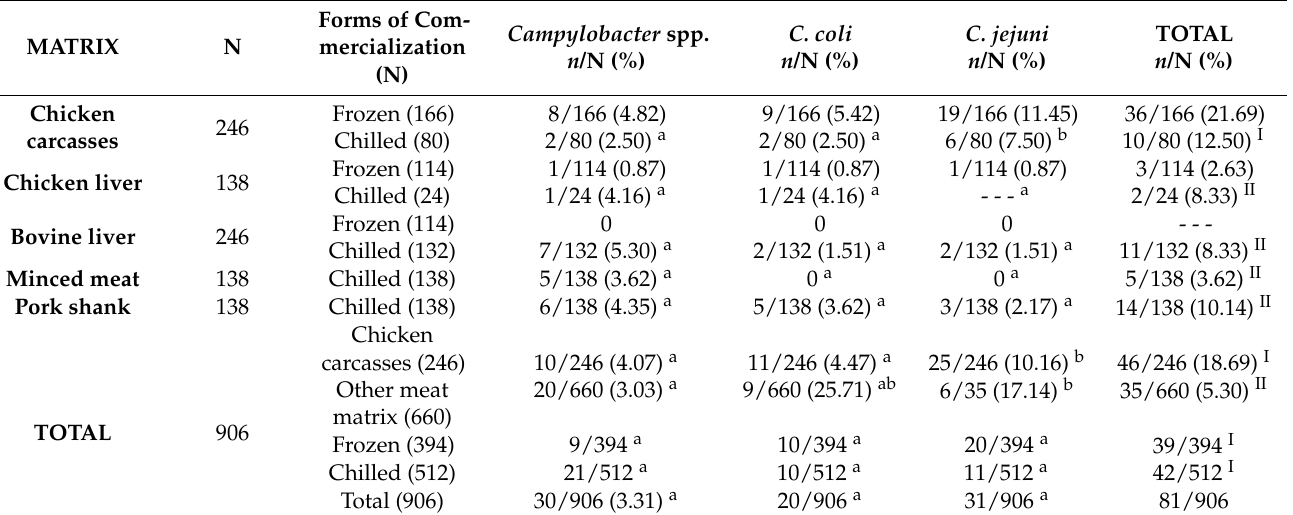
Table 3. Prevalence of Campylobacter spp. in different meat matrices and forms of commercialization in Brazil in the period from 2014 to